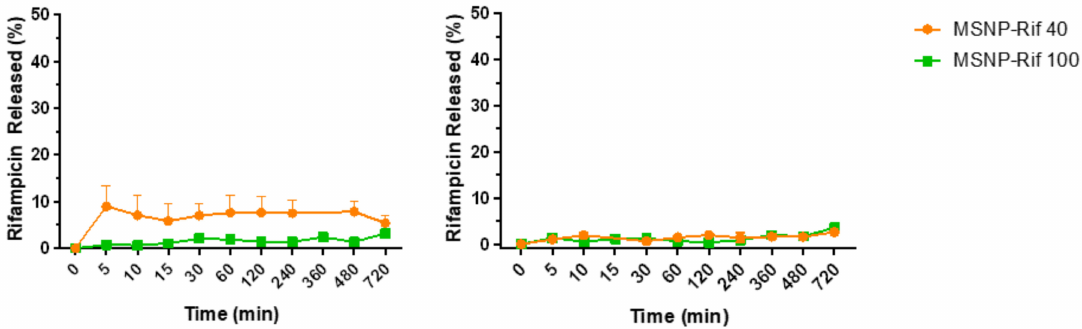
Figure 5. Release kinetics of rifampicin from ( left ) MSNP in phosphate bu ff er solution (PBS) (pH 7.4) and ( right ) acetate bu ff er (pH 5.0) (mean ± SD, n = 3). Note: error bars are smaller than